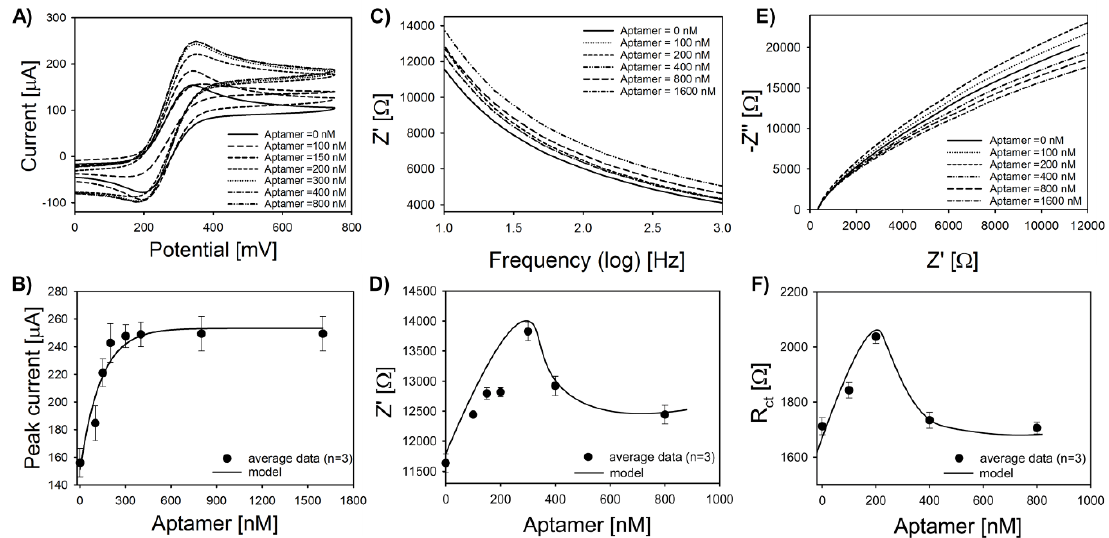
Figure 3. Adsorption of 47-mer on Pt-IME (50 µm gap spacing). ( A ) Representative cyclic voltammetry (CV) at different aptamer concentrations shows an increase in oxidative current after aptamer adsorption in 4 mM K 4 Fe(CN) 6 + 1 M KNO 3 (pH = 7.1) at room temperature. ( B ) Average peak oxidative current from CV. ( C ) Representative Bode plots at different aptamer concentrations impedance after aptamer adsorption. ( D ) Average net impedance at a cuto ff frequency of 1 shows an increase in impedance after aptamer adsorption. ( D ) Average net impedance at a cutoff frequency of 1 Hz from Bode plots. ( E ) Representative Nyquist plots at different aptamer concentrations shows an increase in impedance after aptamer adsorption. ( F ) Average charge transfer resistance from Nyquist plots. All error bars represent standard deviation of the arithmetic mean (n = 6 replicate electrodes). Exponential models were based on Langmuir kinetics, Frenudlich kinetics, or log normal modeling, a 4-parameter empirical model was developed for analyzing data from Bode and Nyquist plots.